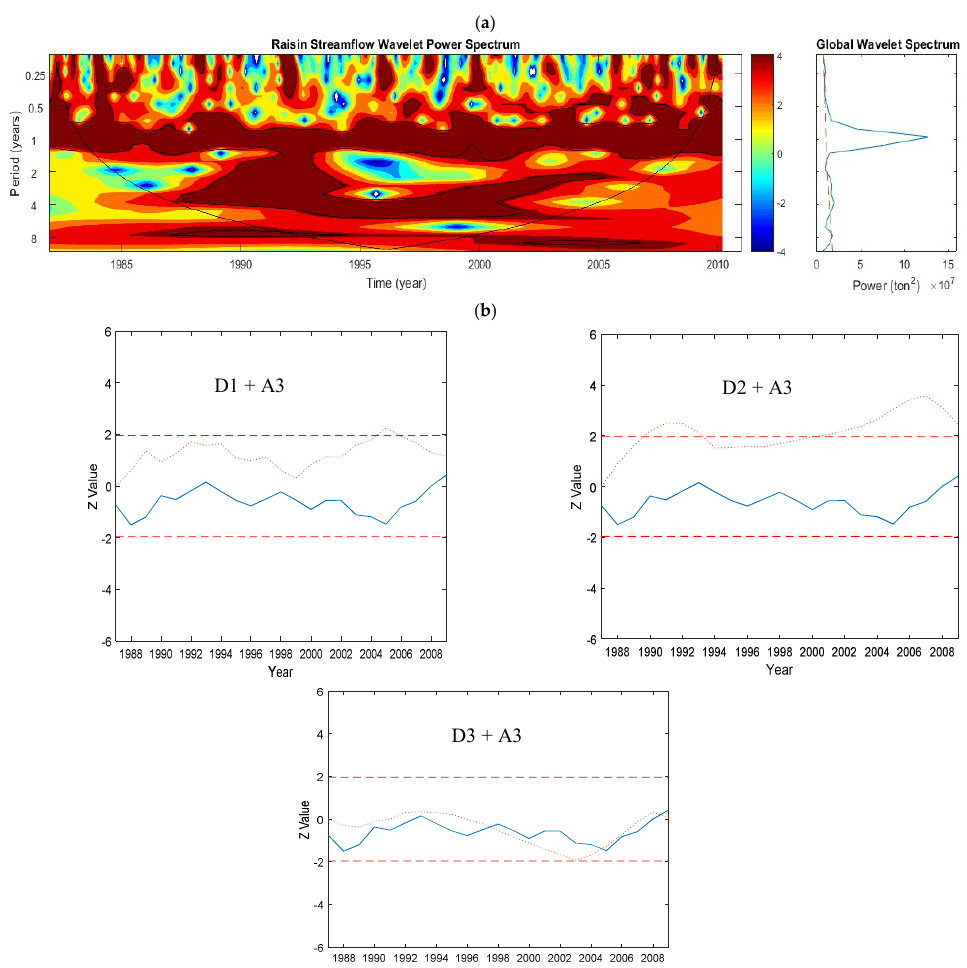
Figure 5. Raisin River: ( a ) Wavelet power spectrum of daily Streamflow. ( b ) Plots of the sequential Mann–Kendall analyses on the Details (with added Approximation component) of the annual streamflow data. The top and bottom dashed lines are ±1.96, which are the confidence limits of the MK test using α = 5%. The solid and dotted lines show the sequential MK values for the original data and the Detail components, respectively. For this streamflow data, the D3 (8 years) component was the most dominant periodicity for trend.